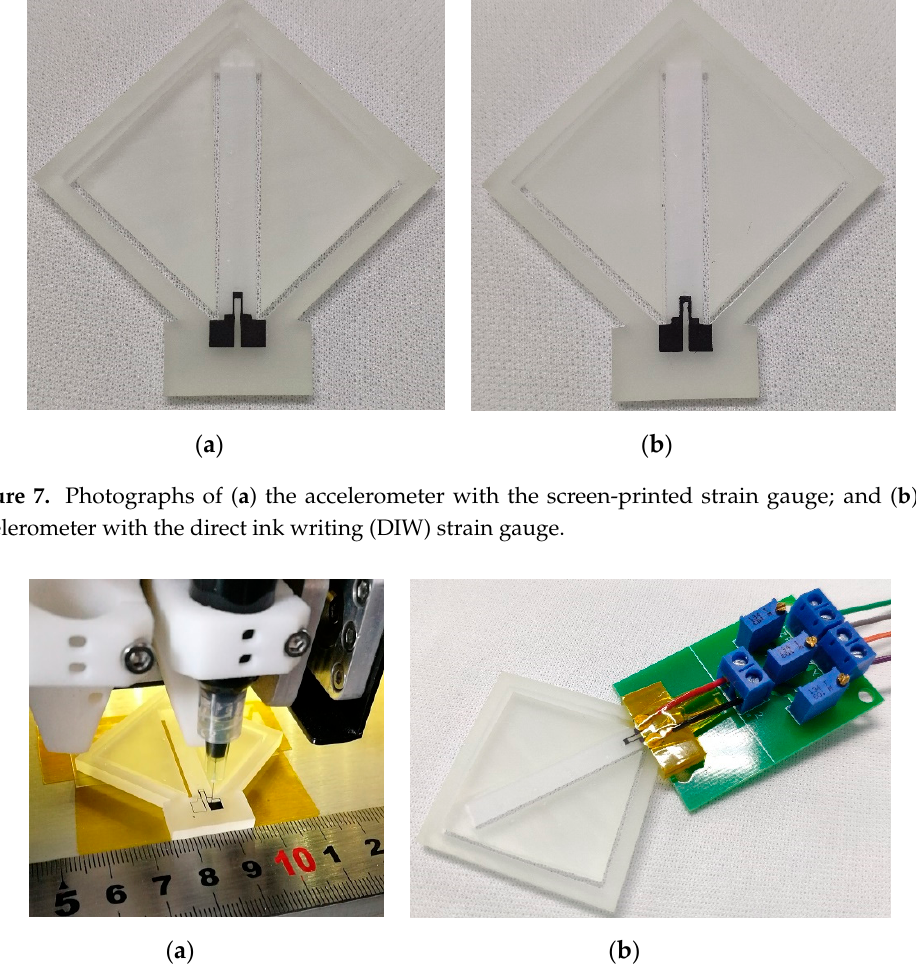
Figure 8. Photographs of ( a ) the strain gauge during the DIW process; and ( b ) the fabricated accelerometer with the measuring circuit.